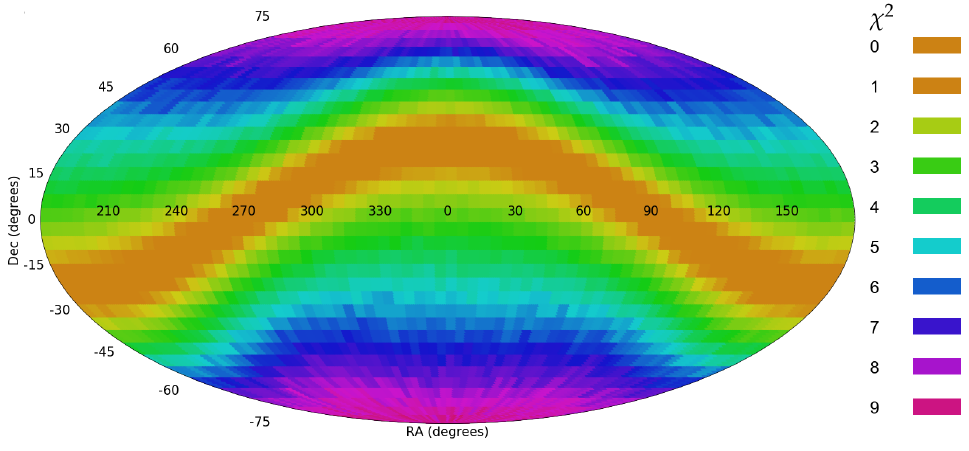
Figure 15. The χ 2 probability of a dipole axis in spin directions when 2% of the counterclockwise galaxies are assigned with clockwise spin